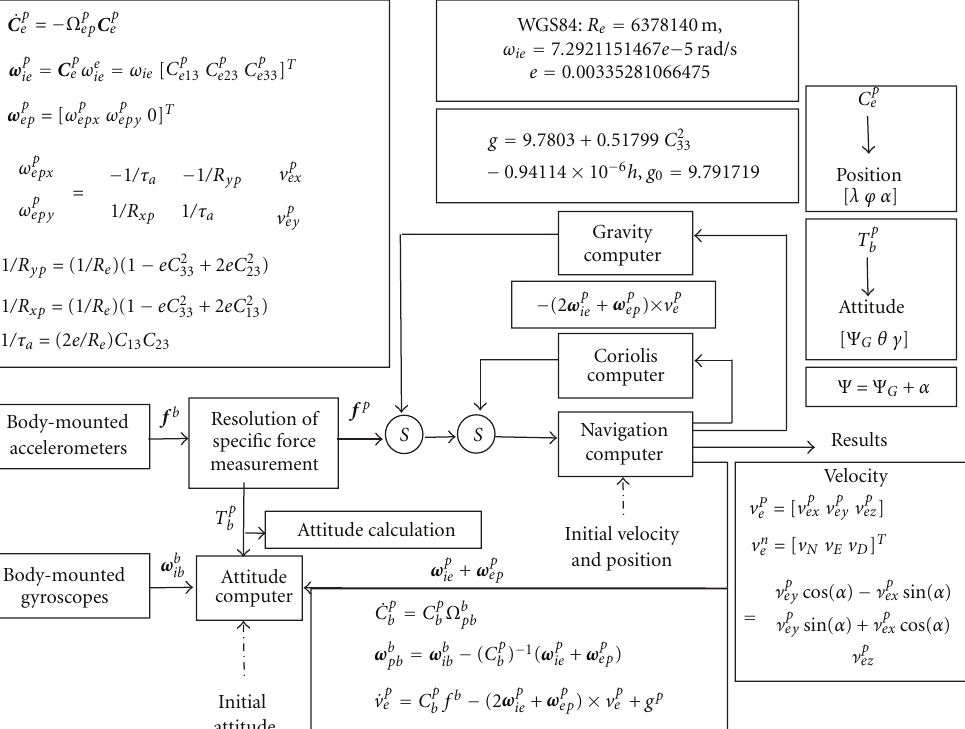
Figure 7: SINS p -frame mechanization.